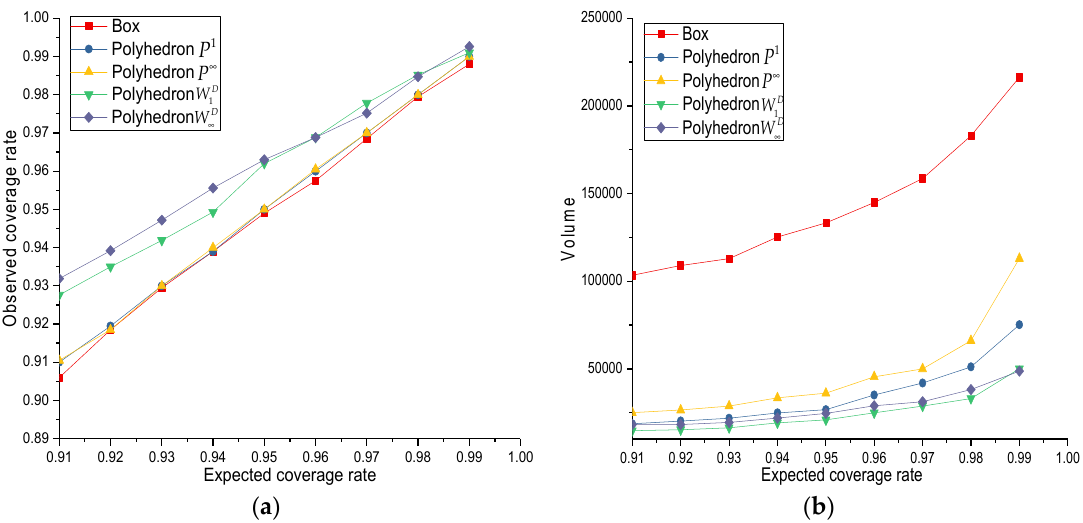
Figure 4. ( a ) The relationship between the expected coverage rate and observed coverage rate, dimension 4; ( b ) the estimated volume of the uncertainty set under a different expected coverage rate, dimension 4.